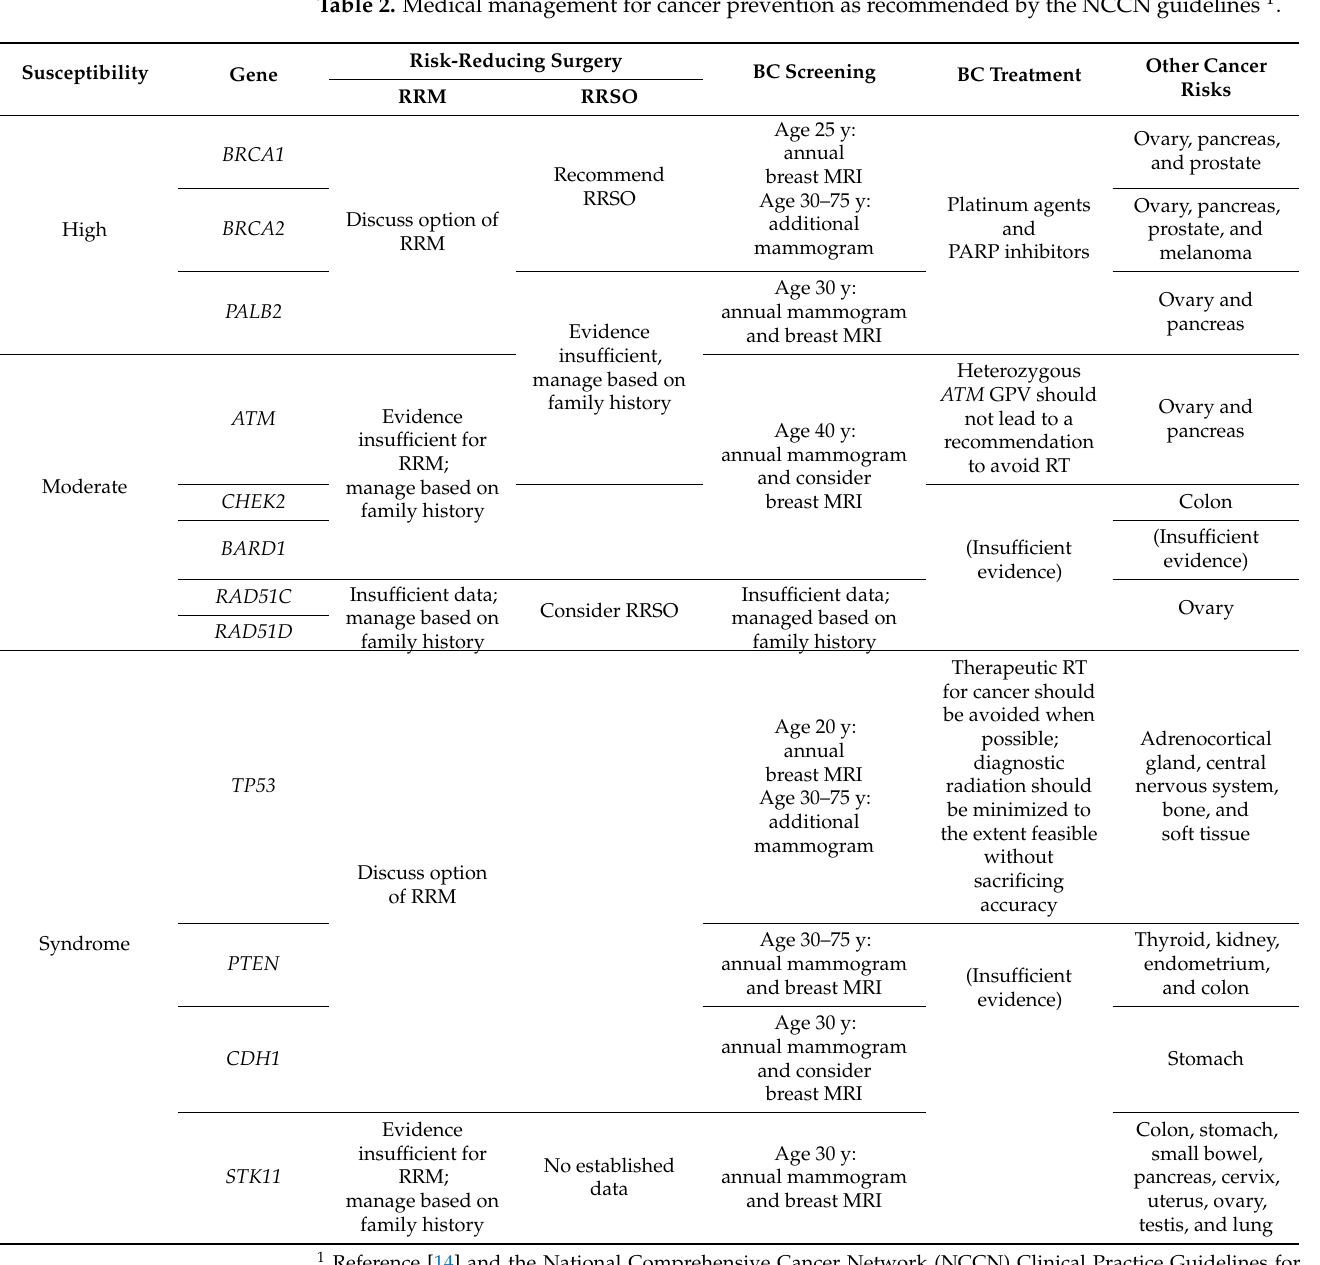
Table 2. Medical management for cancer prevention as recommended by the NCCN guidelines 1